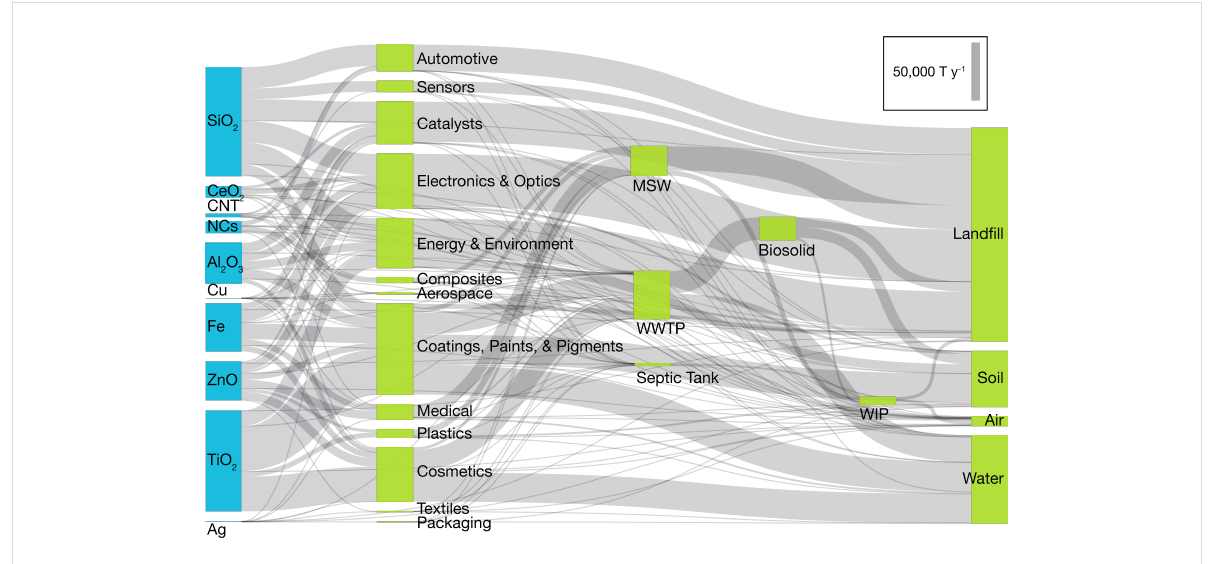
Figure 4: Sankey diagram depicting the flows of different ENMs from production and use, through technical compartments, to disposal and release to the environment. The vertical size of the bars and thickness of the links represent the magnitude of the ENM mass transfer rate.